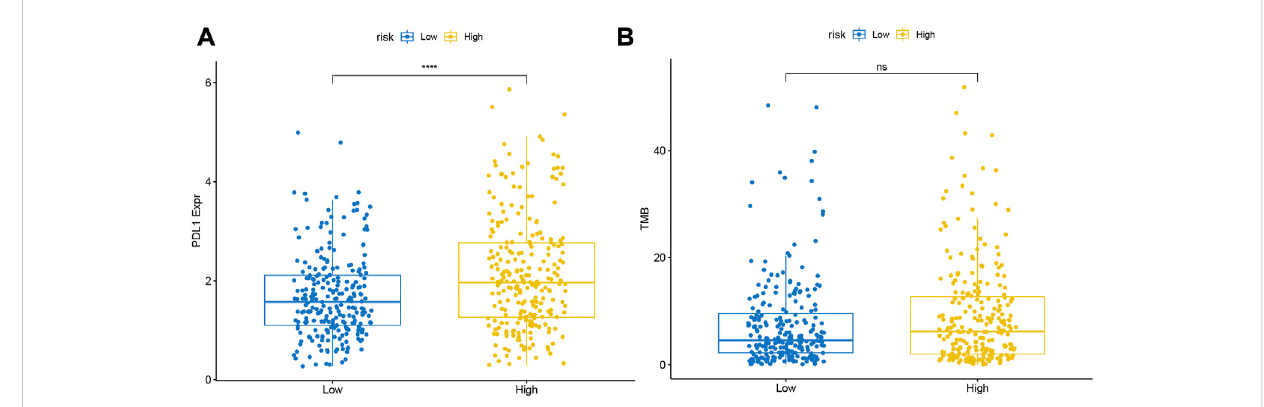
FIGURE 11 Differences in the expression levels of (A) PDL1 and (B) TMB between the high- and low-risk groups.